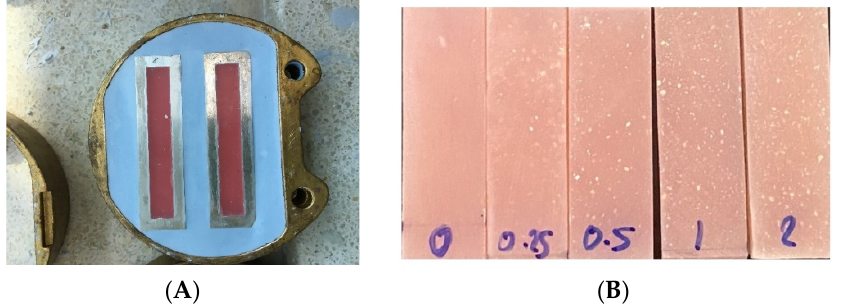
Figure 3. ( A ) The stainless-steel workpiece mold. ( B ) The five groups of NCC-reinforced acrylic resin workpieces.